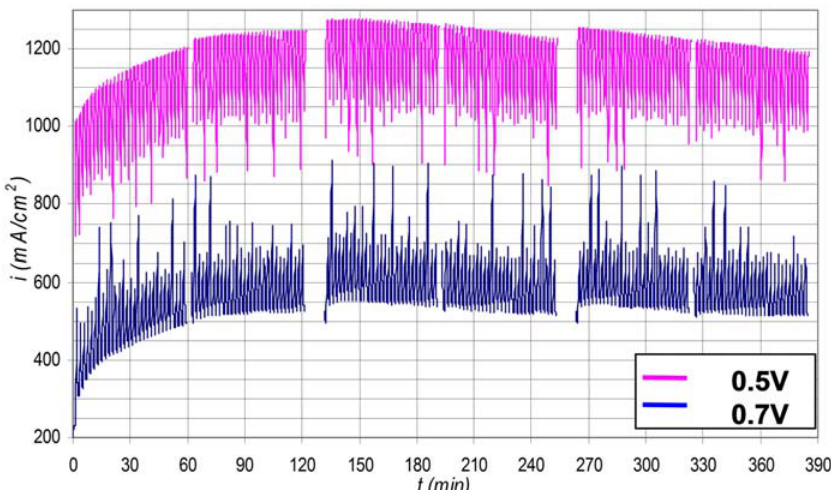
Fig. 2. Initial conditioning by potential